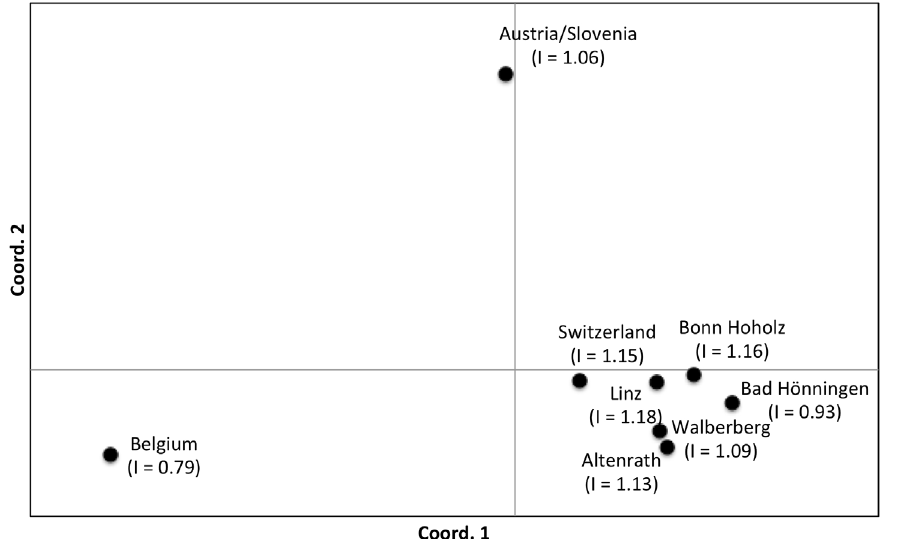
Figure 3. Principal coordinate analysis plot of pairwise F ST genetic distances for the five German populations and samples from Belgium, Switzerland, and Austria/Slovenia. For sample sizes please refer to Table 1. Values in parentheses are Shannon diversity indices (I). Coordinates 1 and 2 account for 86.6% of the variation.